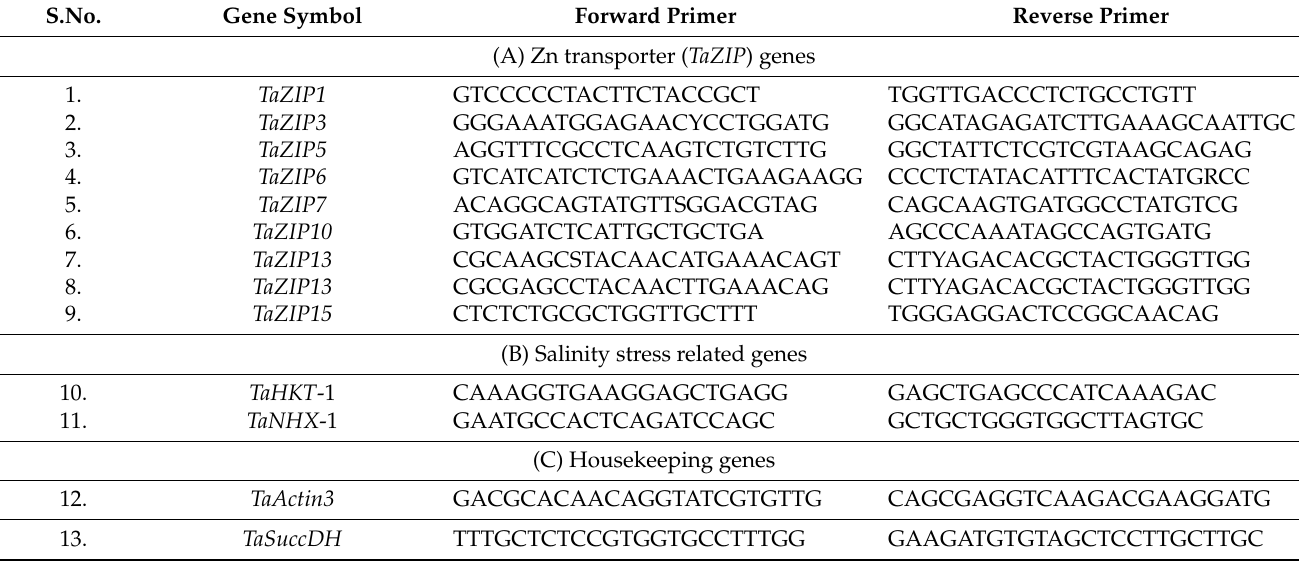
Table 1. Oligonucleotide primer sequences used for SYBR Green real time qPCR expression analysis.